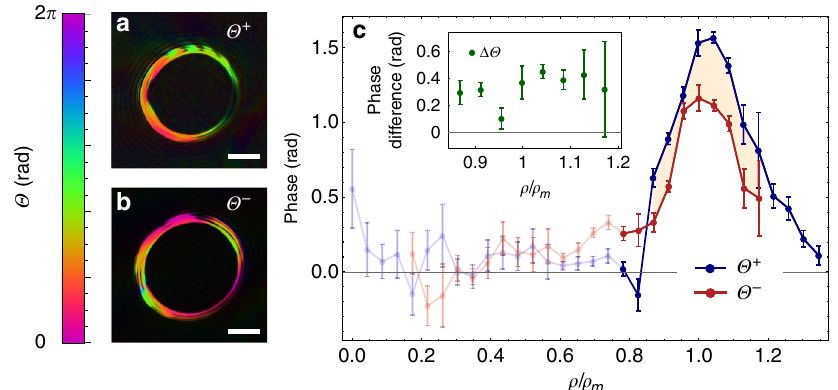
Fig. 4 Experimentally observed phase shift of twisted electron beams upon interaction with a magnetic pillar. a and b show the digitally reconstructed phase shift for beams carrying OAM values of + 200 and − 200, respectively. Scale bar represents 100 nm. c The points indicate the experimental data for measured relative phase changes that are obtained by the electron interferometer shown in Fig. 3. The error bars are based on standard deviations in different sets of measurements. Red and blue colors are the measured phases for beams carrying positive Θ + and negative Θ − OAM values of 200, that is, ‘ ¼ ± 200 : The relative phase Δ Θ is illustrated by the beige shaded area . These data were evaluated for regions close to ρ transparent zones indicate regions where the probability of fi nding electrons is zero. The solid lines are obtained by